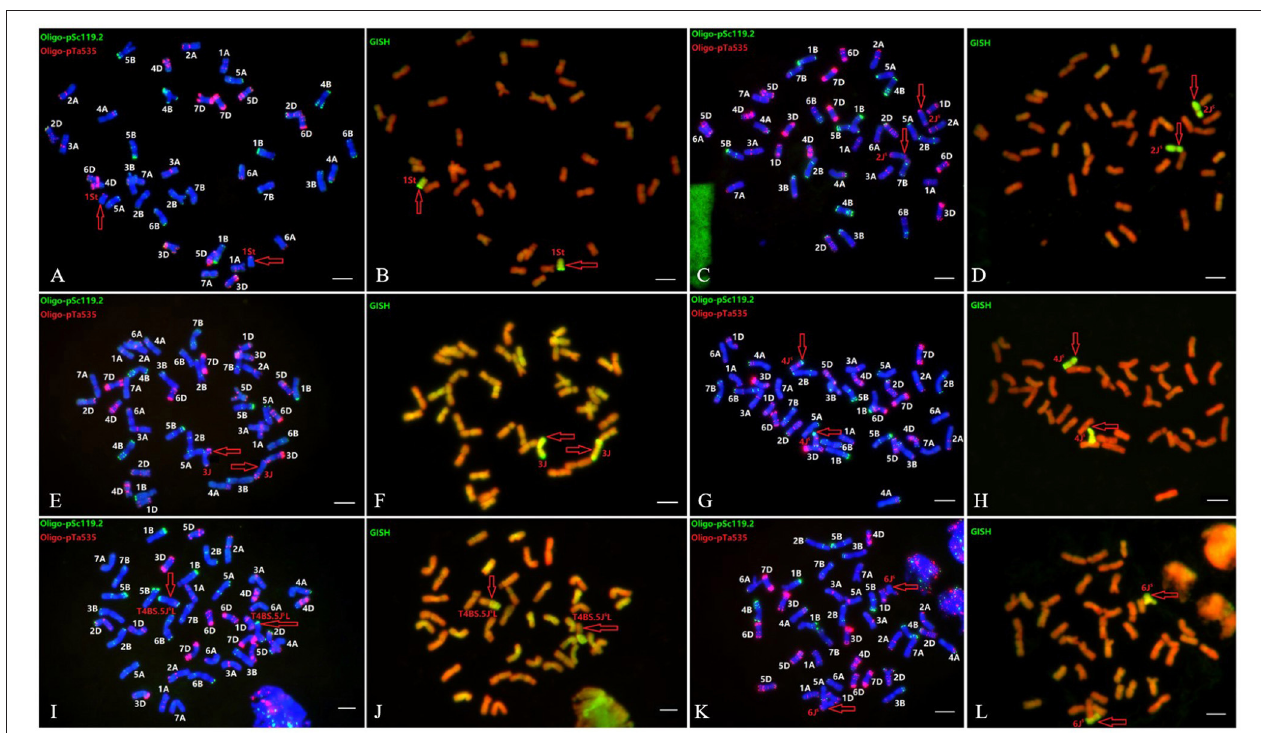
FIGURE 4 | Sequential FISH and GISH patterns of six wheat- Th. intermedium introgressions with single alien sub-genome from Thi -HG1-6, respectively. (A,B) substitution line AS1677 [ABD + 1St(1D)]; (C,D) addition line X24C14 (ABD + 2J s ); (E,F) addition line A1082 (ABD + 3J); (G,H) substitution line A1125 [ABD + 4J s (4B)]; (I,J) translocation line A39 (ABD + T4BS.5J s L); and (K,L) substitution line XM-4 [ABD + 6J s (6B)]. The probes for FISH were Oligo-pSc119.2 (green) + Oligo-pTa535 (red) (A,C,E,G,I,K) . The probe (yellow-green) for GISH analysis was Th. intermedium total genomic DNA (B,D,F,H,J,L) . Bars, 10 µ